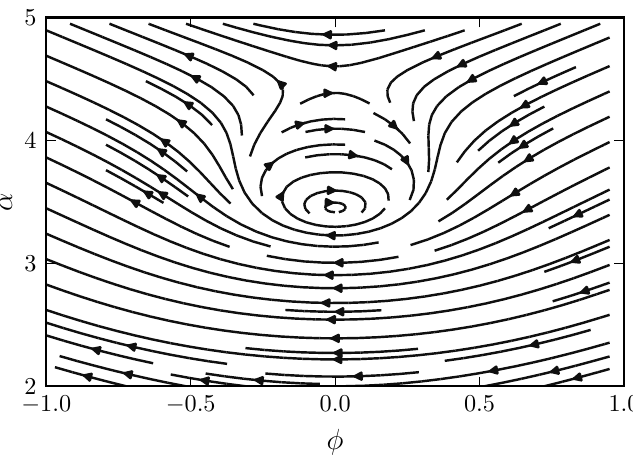
Figure 5. Phase space for the quantum bounce [89]. There are bounce and cyclic solutions. The bounces in the figure correspond to case B, where ˙ ϕ < 0. They connect regions around S + in the contracting phase with regions around S in the expanding phase. −